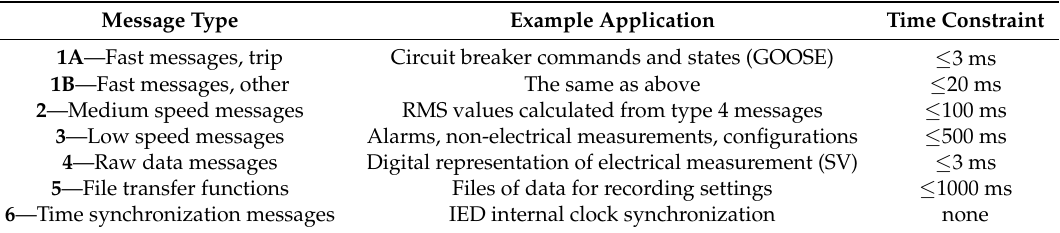
Table 1. Time constraints for IEC 61850 process bus messages.